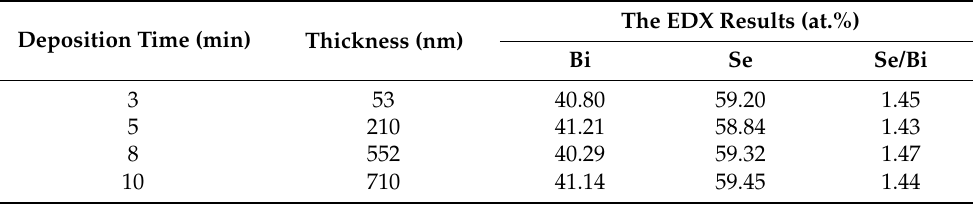
Figure 2. ( a – d ) FESEM image of typical Bi2Se3 films grown on an LSMO/LAO substrate. ( e ) TEM images of Bi 2 Se 3 /LSMO/LAO with t = 8 min.